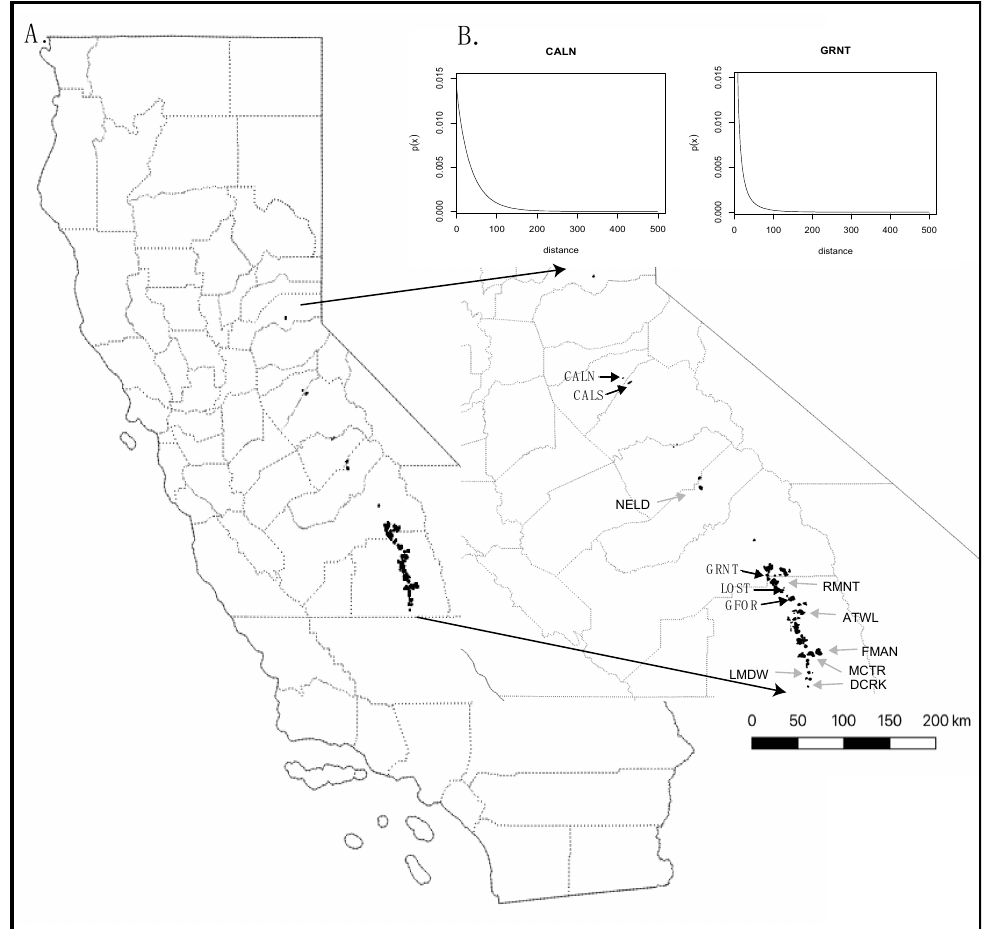
Figure 1. ( A ) Range map of giant sequoia. Populations where leaf or seed collection occurred are noted by a population code. Leaf tissue was collected in all noted locations, black arrows indicate seed collection sites. ( B ) Pollen dispersal kernels for two giant sequoia populations, CALN (left) and GRNT (right) estimated in TwoGener by fitting an exponential power distribution with effective density set to ½ census density.